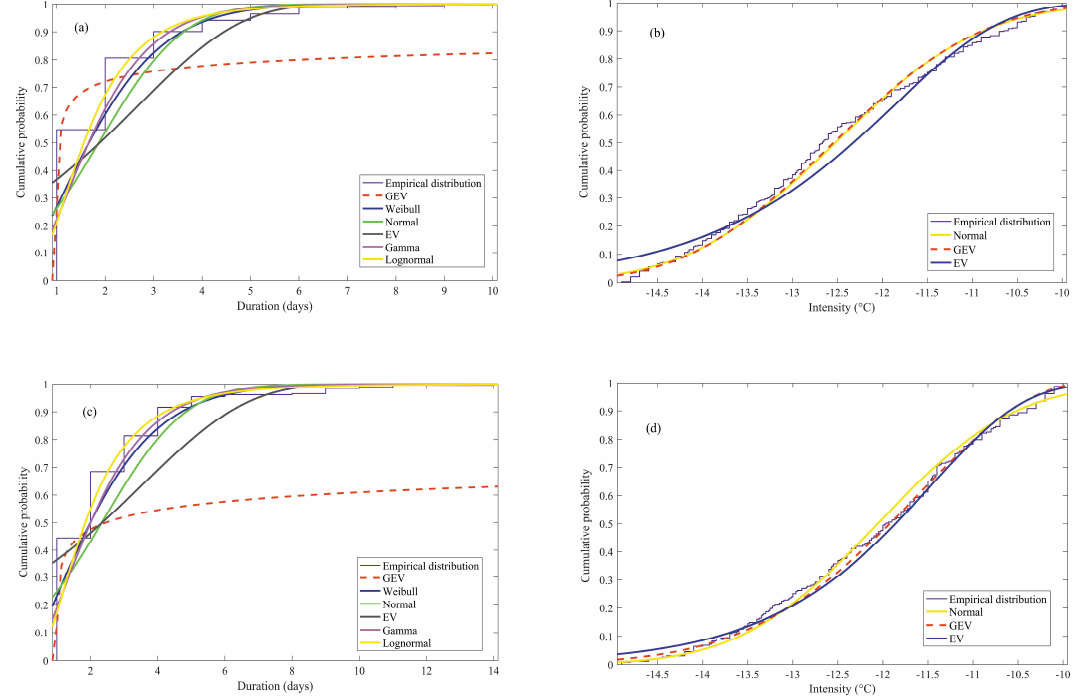
Figure 2. Marginal distributions for low temperature event duration ( a , c ) and intensity ( b , d ) for Yanqing station for the study periods 1978–1998 ( a , b ); and 1999–2015 ( c , d ). EV—extreme value; GEV—generalized EV. Table 4. The goodness-of-fit based on the Kolmogorov–Smirnov (K–S) D statistic for marginal distributions of duration and intensity for low temperature events at 20 meteorological stations in Beijing. EV—extreme value; GEV—generalized